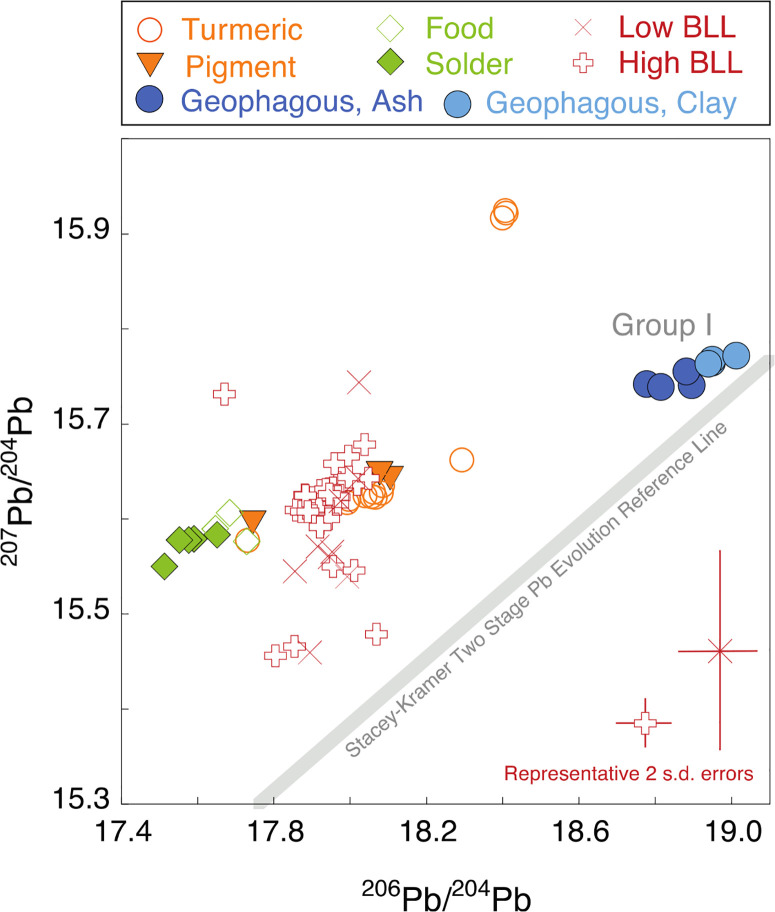
Comparison of isotope ratios (207Pb/204Pb vs 206Pb/204Pb) in women’s blood relative to Pb-soldered cans, food from Pb-soldered cans, ash, clay, turmeric, and yellow pigment collected from study participants and surrounding markets in Tangail, Mymensingh, and Kishoreganj, Bangladesh, 2015−2017. The two-stage Pb evolution line, the 3.7 Ga isochron, is shown for ref 44. Note that the scale has changed from Figure 1. Typical errors on high and low BLL samples are provided for reference (see Table S7).